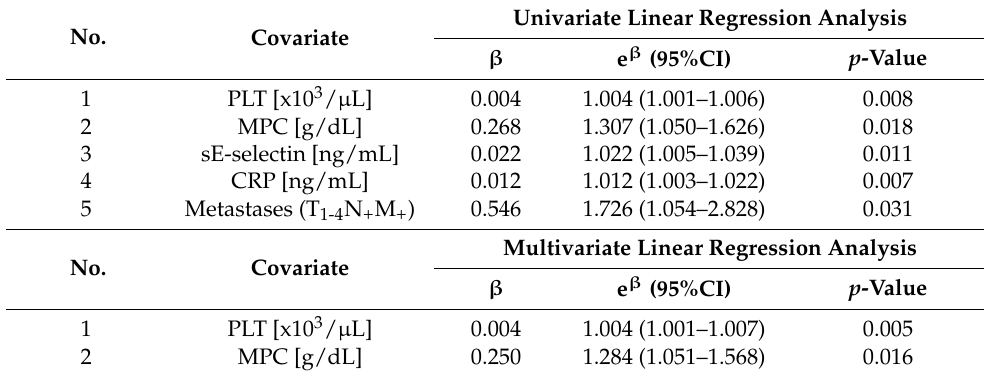
Table 3. Univariate and multivariate linear regression analysis results for IL-6 in colorectal cancer patients.